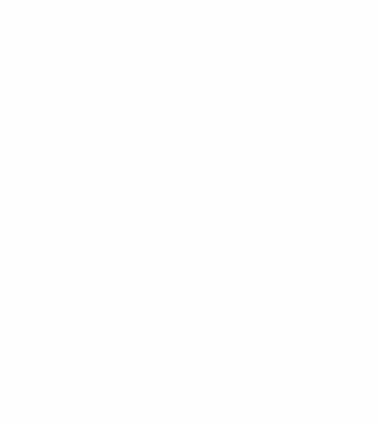
FIGURE 3. Immunohistochemical characterization of cells in ileal PP lymphoid follicles following treat- ment with 2 mg dexamethasone/kg BW for 7 days. a: The stain for mes- enchymal cells (vimentin) revealed a network of cells in the lamina propria of the villi, numerous cells within the dome (d) and interfollicular region (if), the majority of cells within the follicular remants (f), and cells scat- tered throughout the muscularis (ms). b: The stain for macrophages (Du2- 66) revealed scattered cells (solid tri- angles) in the dome region (d) and many cells (solid triangles) scattered throughout the follicular remnants (f). c: The stain for CD4 T cells revealed cells scattered throughout the lamina propria, interfollicular re- gion (if), dome (d), and rare cells (solid triangles) within the follicular remnant (f). d: The stain for B cells (CD45R) revealed numerous cells within the dome (d), few cells in the interfollicular region (if), and rare cells (solid triangles) surviving within the follicular remnant (f). Magnifica- tion: a-d (bar [in d] 100